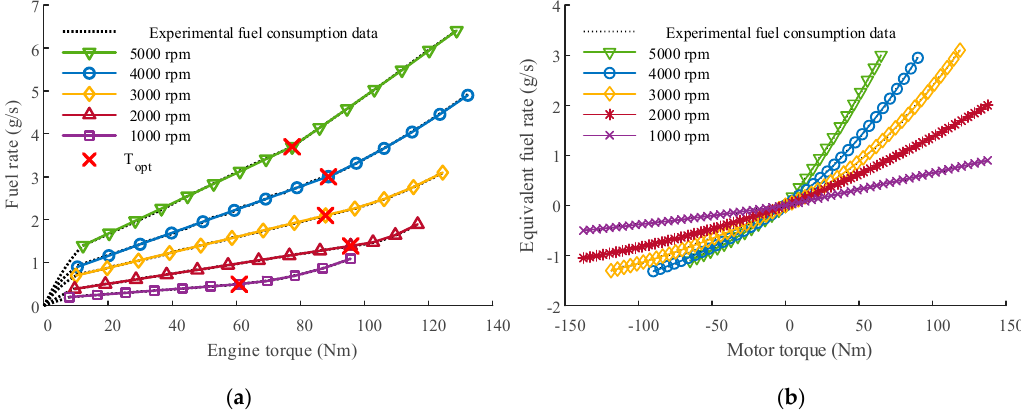
Figure 2. Fitting curve of the equivalent fuel consumption, ( a ) Engine; ( b ) Battery.